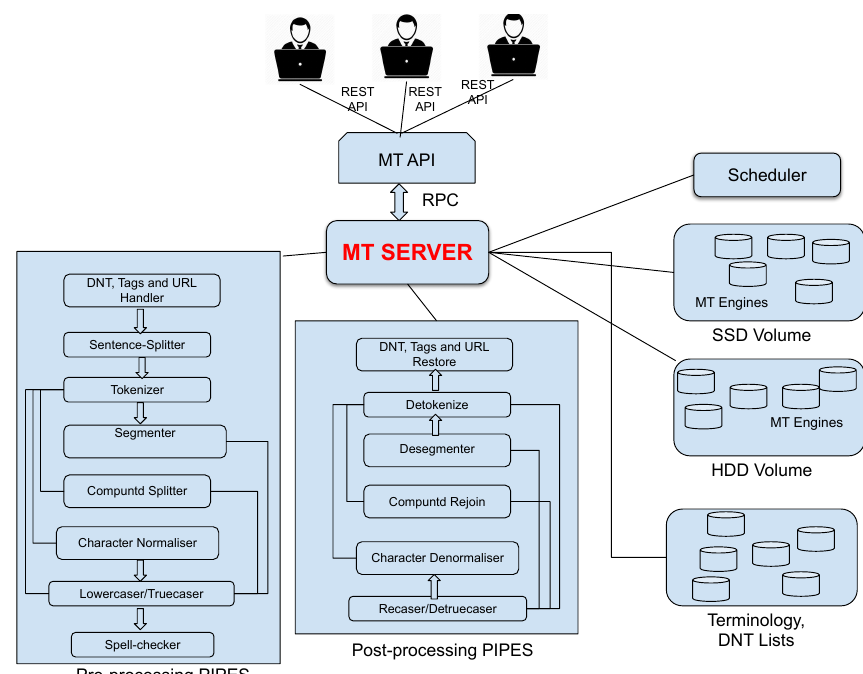
Figure 3. Skeleton of Online MT